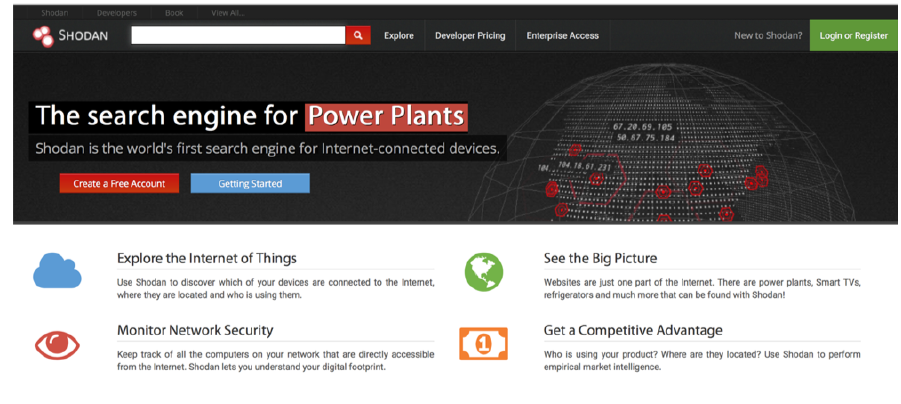
Figure 5. Shodan main web page.